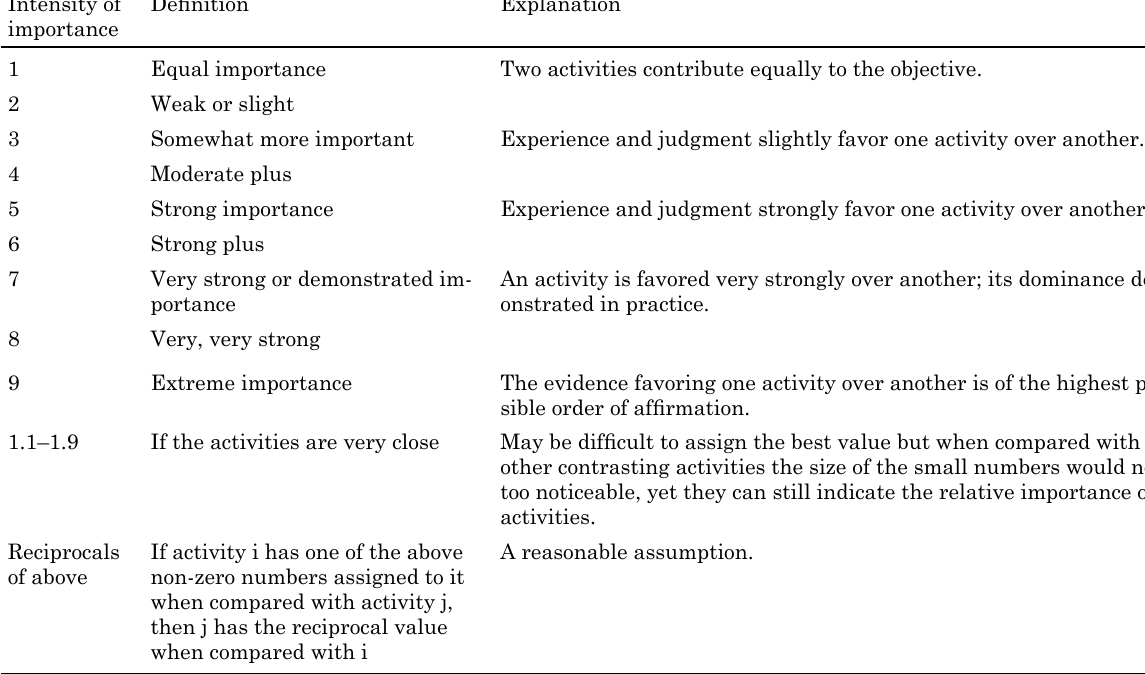
table 1. the fundamental scale of absolute numbers Intensity of